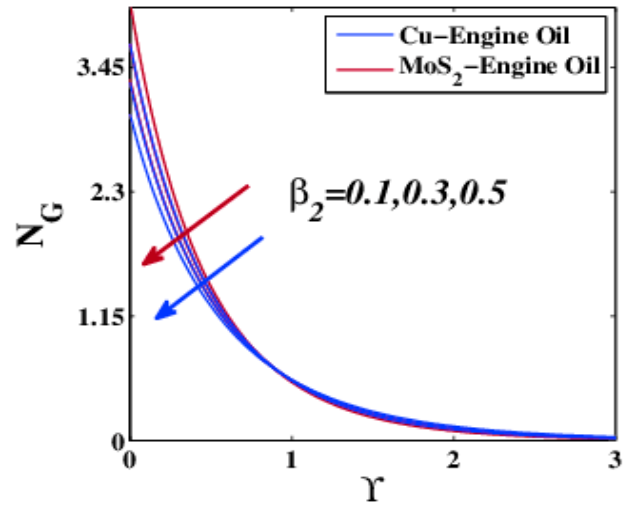
Figure 8. The effect of 𝛽 (cid:2869) on entropy generation variation 𝑁 (cid:3008) .